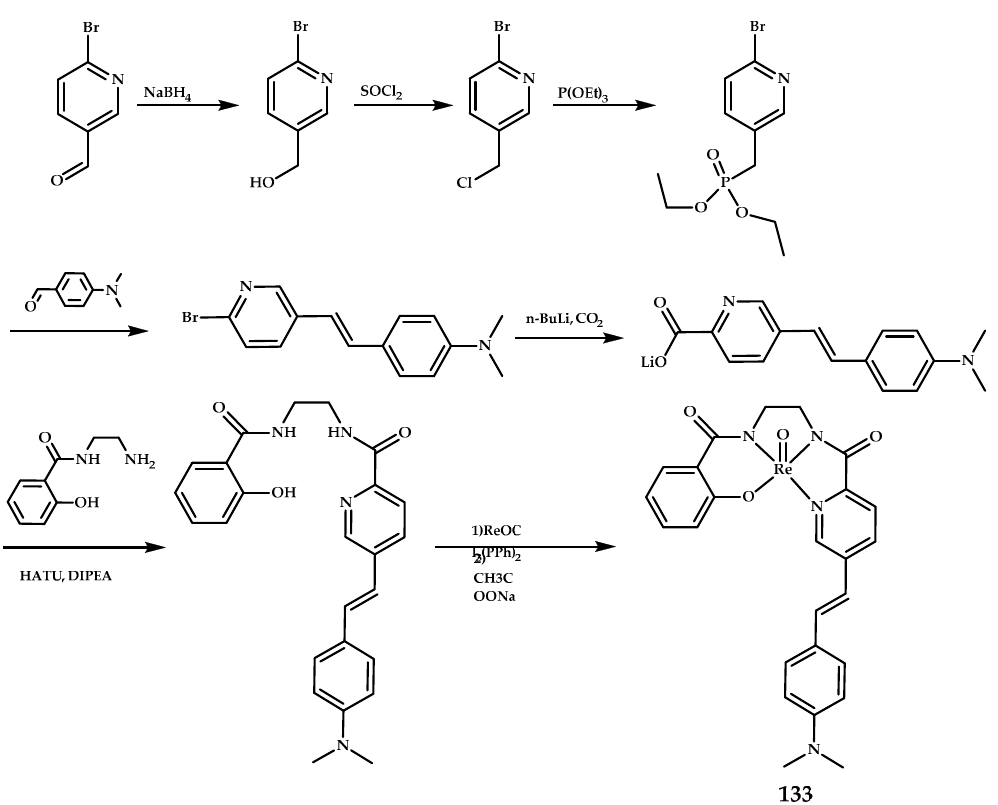
Figure 29. Oxorhenium(V) complexes 133 based on a styrylpyridyl functional group with 2-